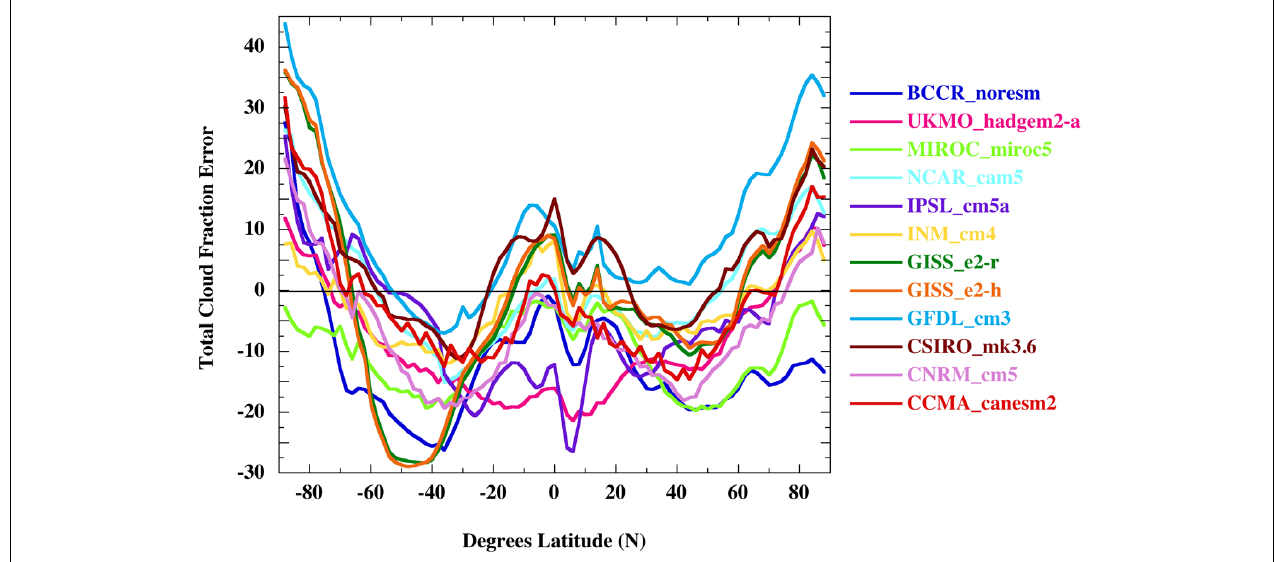
Figure S6-1 of the Supporting Information for further